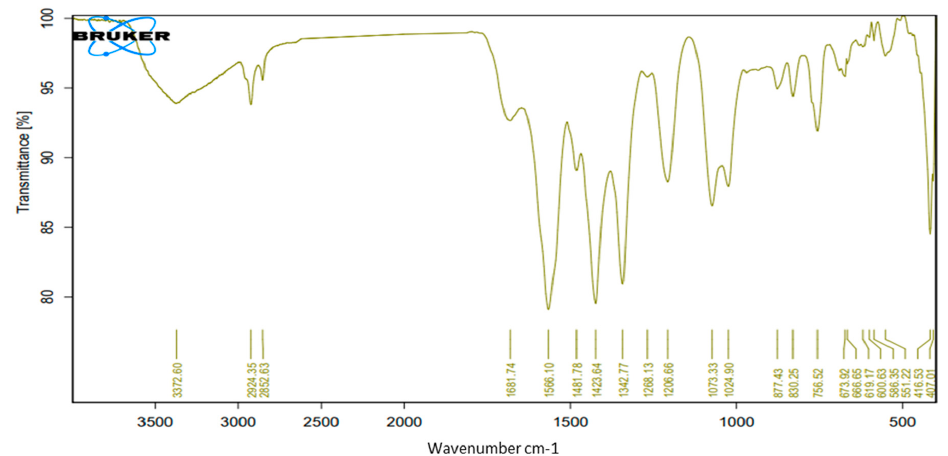
Figure 6. Fourier transform infrared (FT-IR) spectroscopy for ZnO nanoparticles based on P. zonale leaf extract.